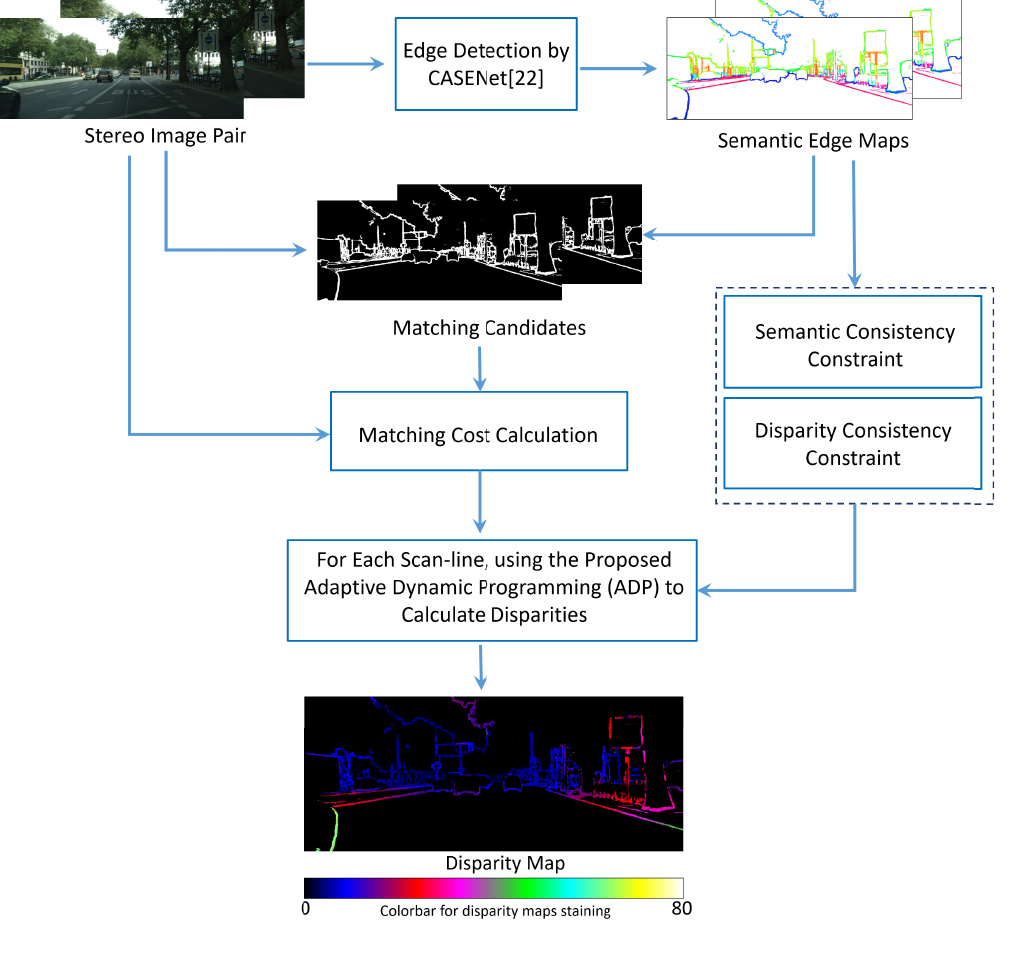
Figure 1. Pipeline of our proposed